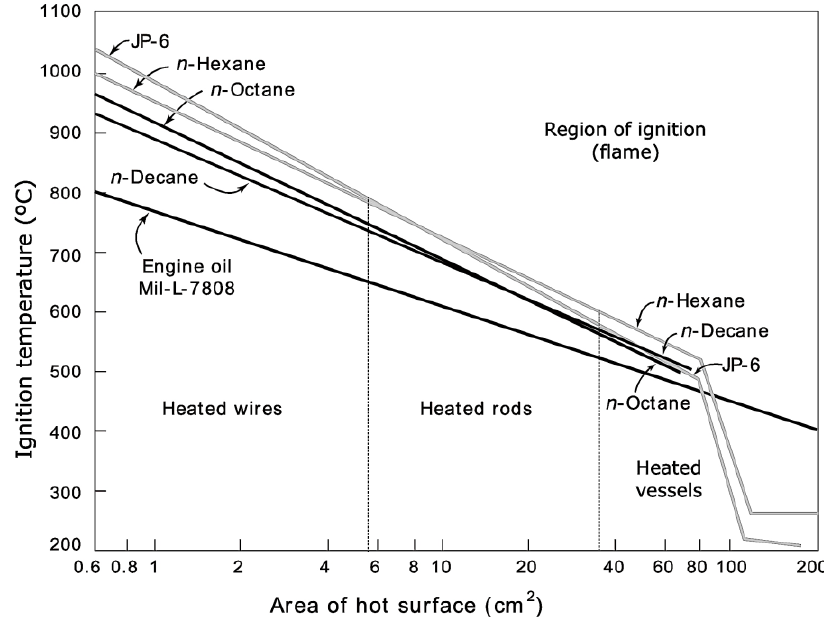
Figure 2. Effect of a hot surface area on the ignition of several types of fuel vapors [6] .